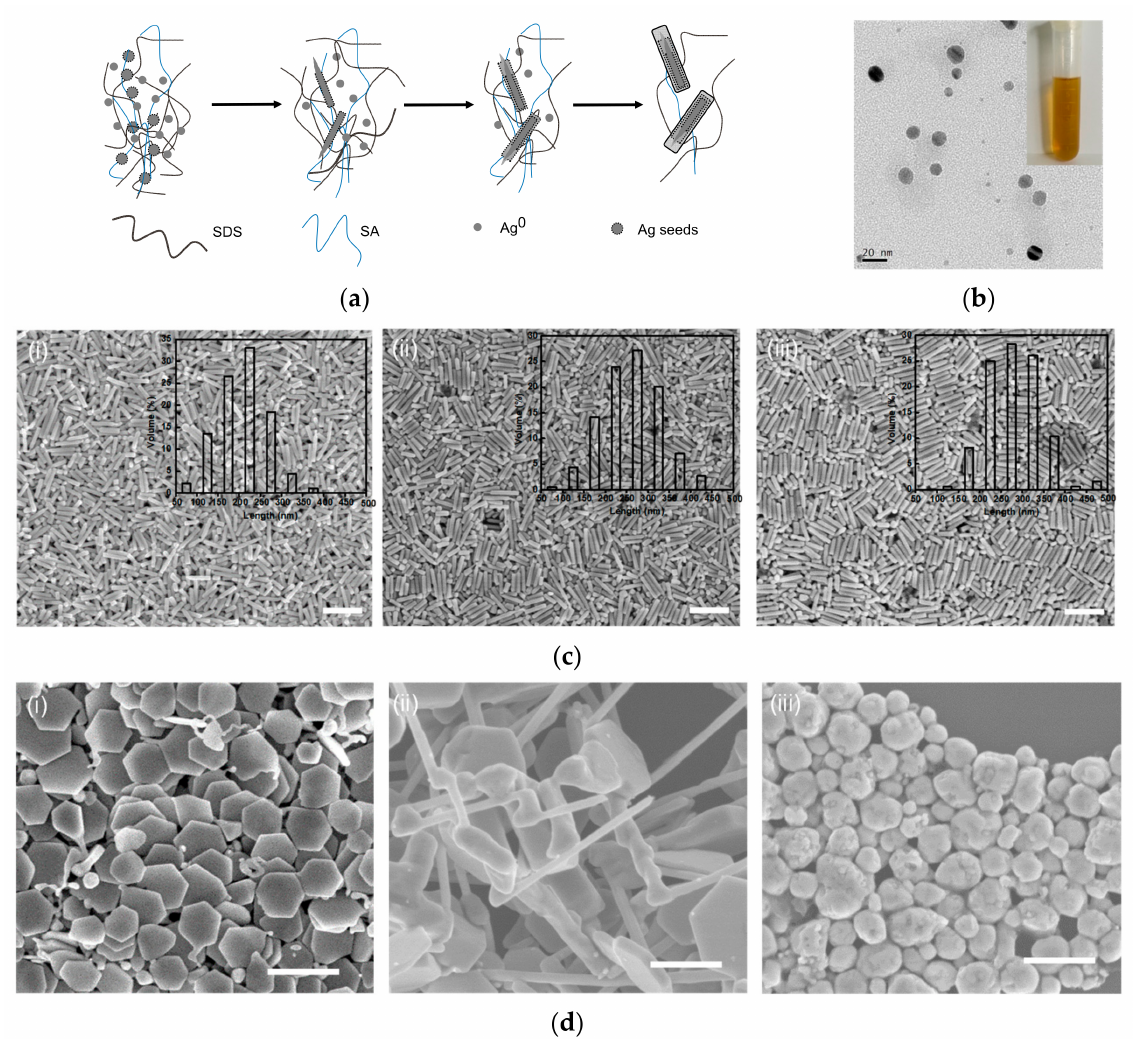
Figure 2. ( a ) Schematic depicting SNPs’ growth from silver nanoparticle seeds. ( b ) The transmission electron microscopy (TEM) image of silver nanoparticles; inset shows silver nanoparticle suspension. ( c ) SEM images and corresponding histograms (as shown in insets) showing the SNPs’ size distribu- tions obtained during synthesis for ( i ) 1 h; ( ii ) 2 h; and ( iii ) 3.5 h. The scale bar is 500 nm. ( d ) The samples of the blank experiments using SA without nanoparticles and reacting for 2 h at ( i ) 0 ◦ C; ( ii ) 27 ◦ C; and ( iii ) 80 ◦ C. The scale bar is 500